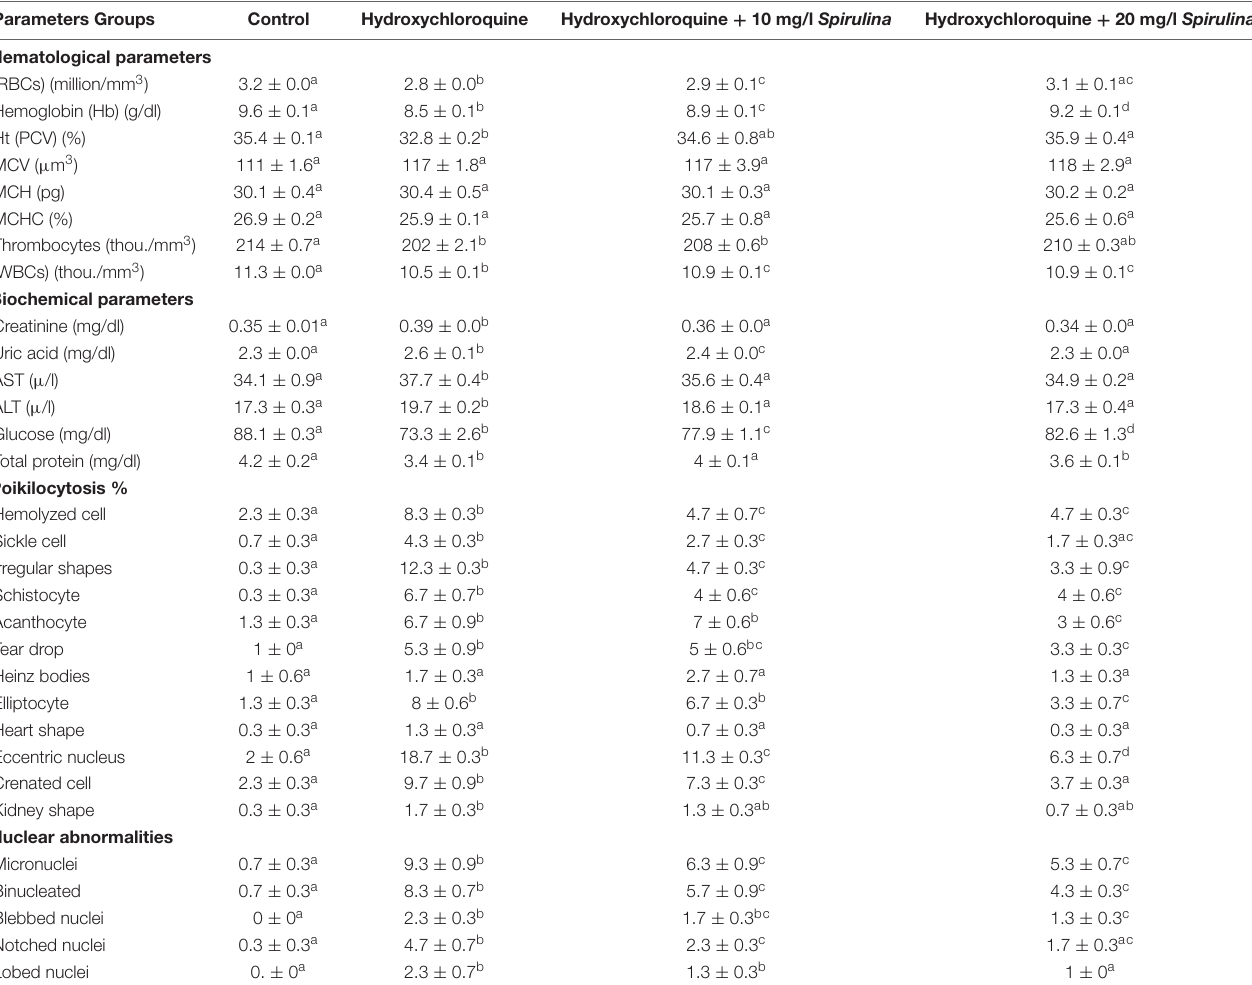
Data are represented as means ± SE. Values with a different superscript letter in the same row for each parameter are significantly different (P < 0.05). n = 6. RBCs, red blood cells; Hb, hemoglobin concentration; HCT, hematocrit; MCV, mean cell volume; MCH, mean cell hemoglobin; MCHC, mean cell